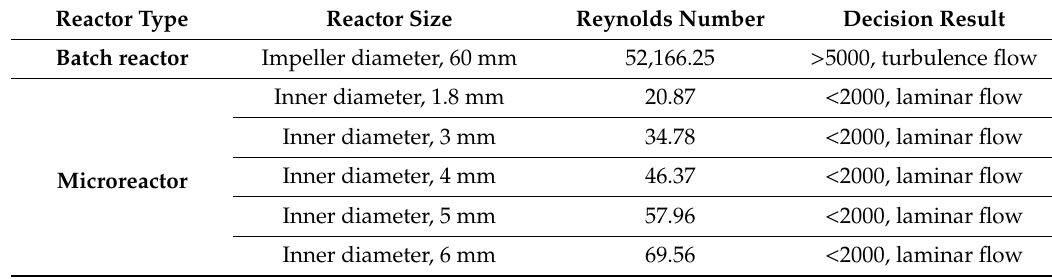
Table 2. Calculated Reynolds numbers and assessments of fluid